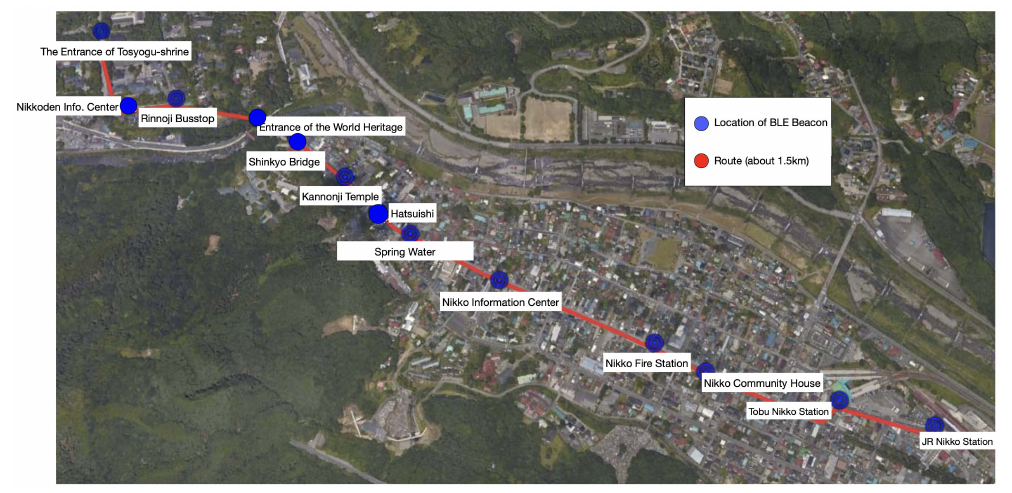
Figure 16. Experiment route.